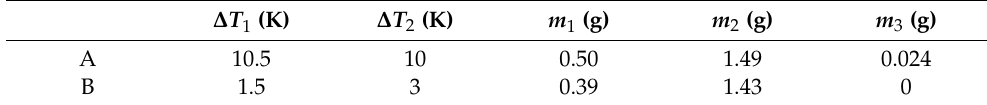
Figure 8. Temperature variation of water and glass tube during the particles collection (solid line) as well as that obtained in the control group (dotted line). Table 4. Corresponding data in particle temperature